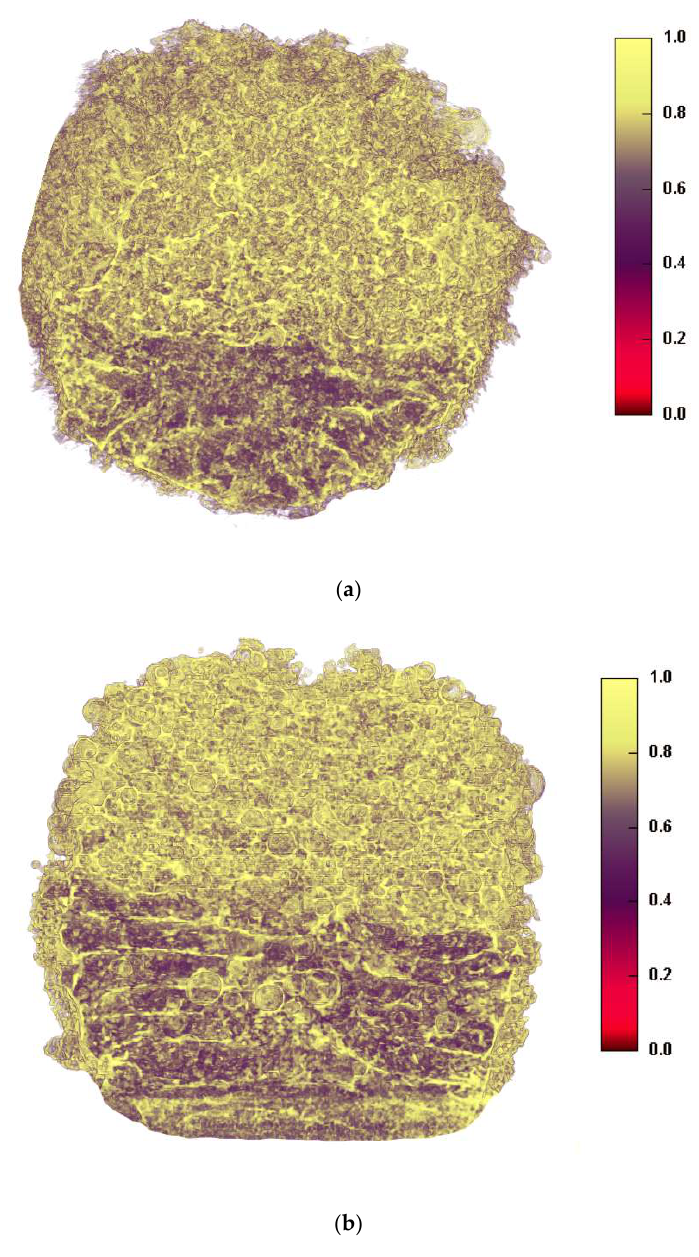
Figure 5. Cross-sectional x-ray micro computed tomography (CT) images of ( a ) Con A and ( b ) Con B of the 2 mm dual miniprintlets. The yellow regions represent the Kollicoat Instant Release (KIR) regions, whereas the dark purple regions are the ethyl cellulose (EC) regions. The scale bar is representative of